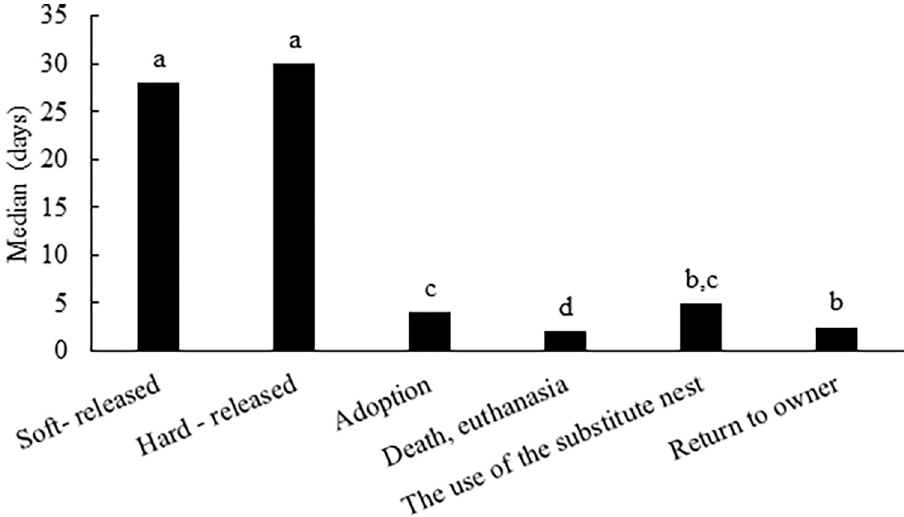
Fig 3. The length of time spent by raptors at rescue centres in the Czech Republic by outcome. a-d The values in columns with different superscript letters are significantly different (p < 0.05).